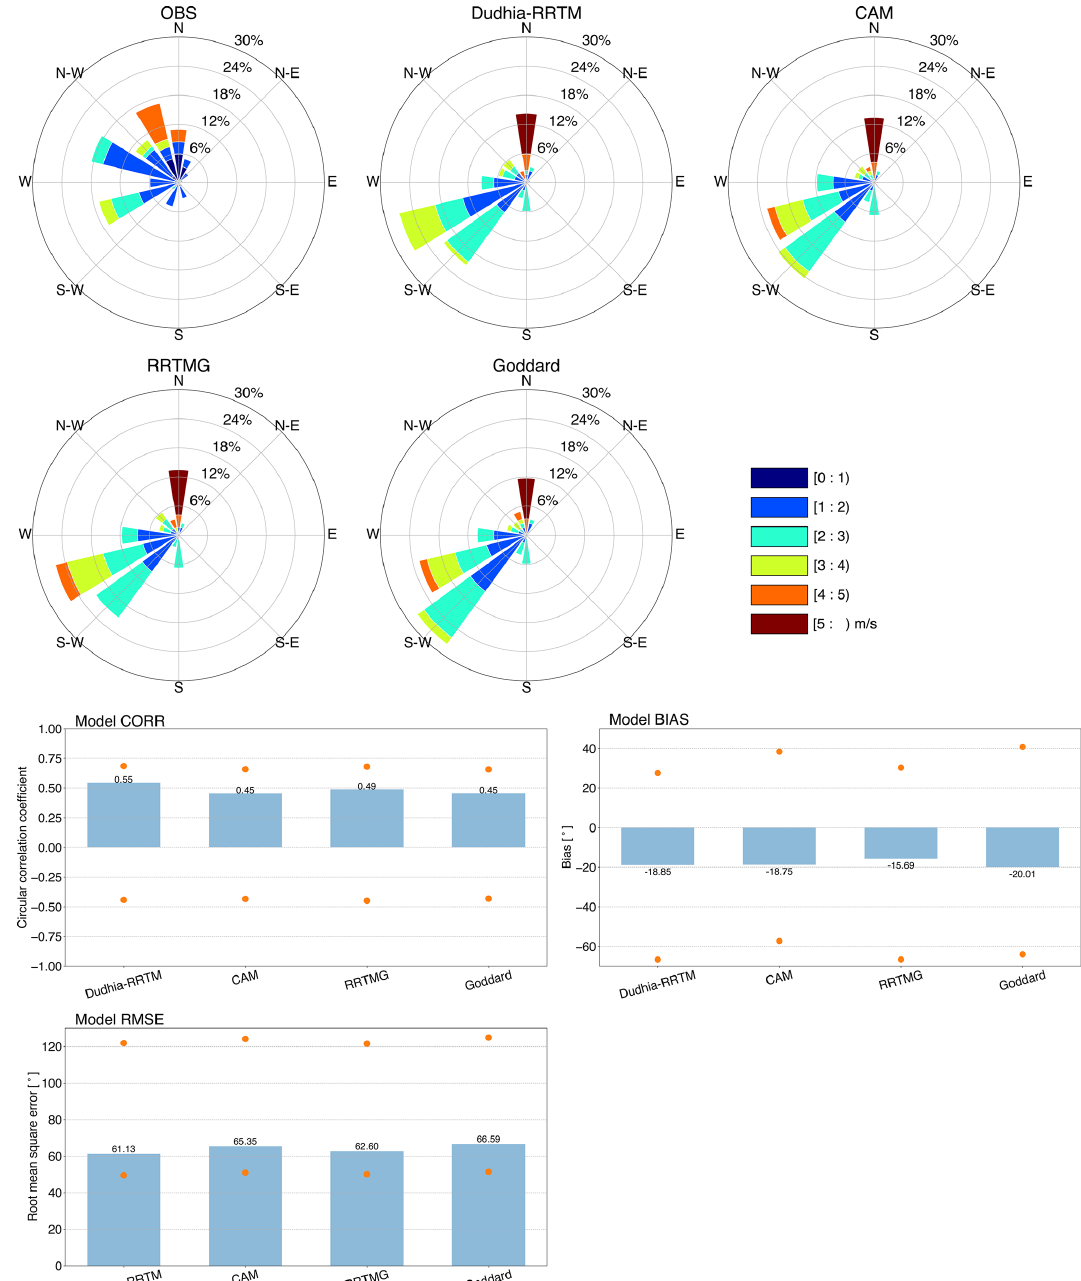
Figure 8. Same as Fig. 4, but for the radiation